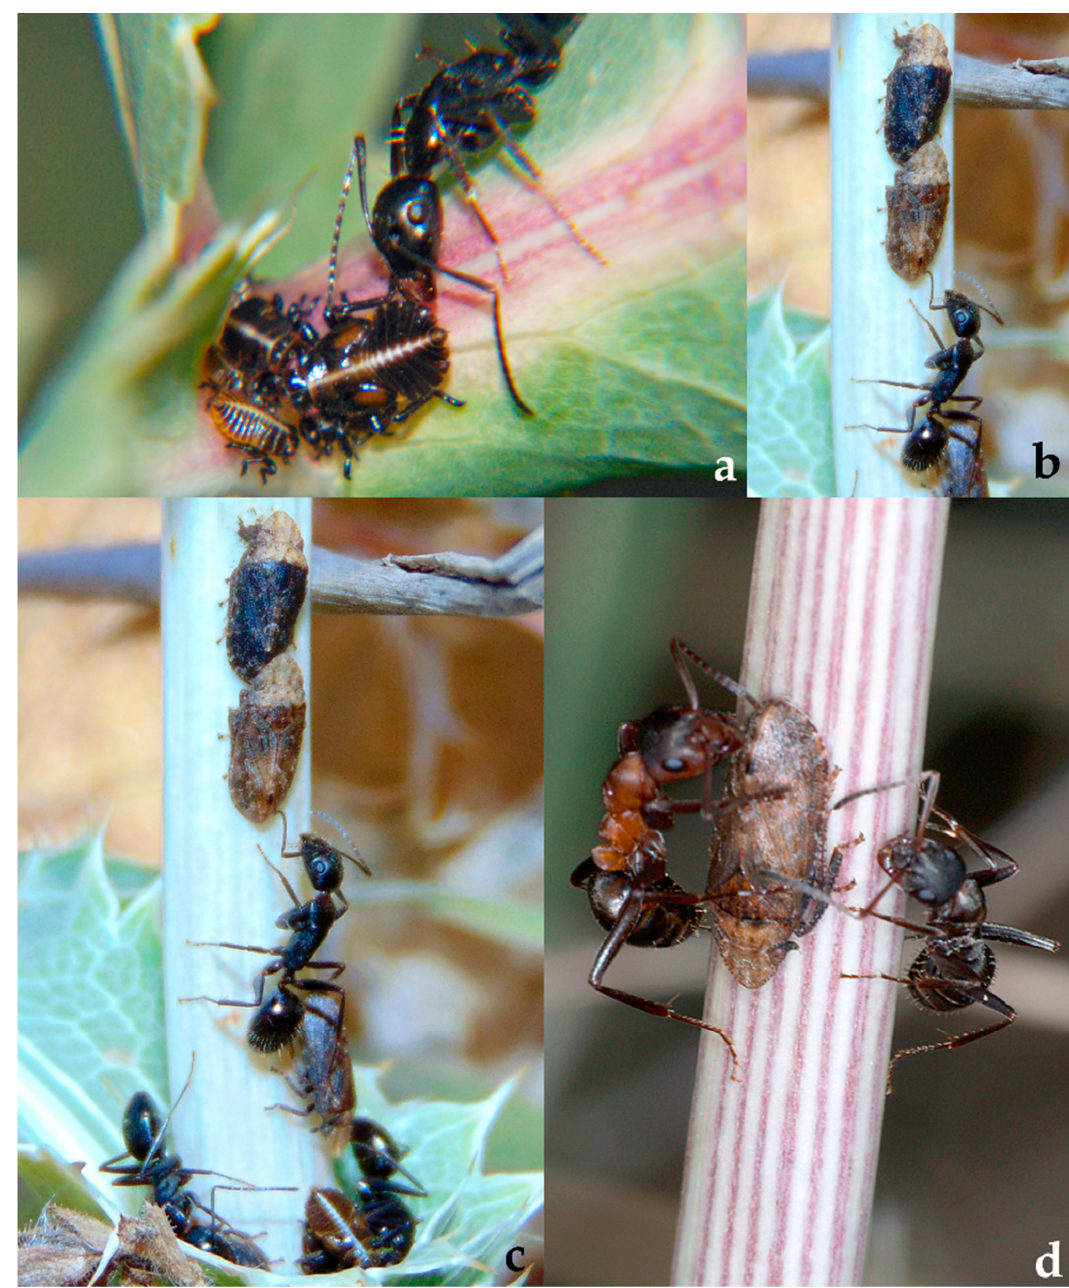
Figure 34. Tettigometridae: ( a ) Tettigometra ( Mitricephalus ) macrocephala Fieber, 1864 tended by For-